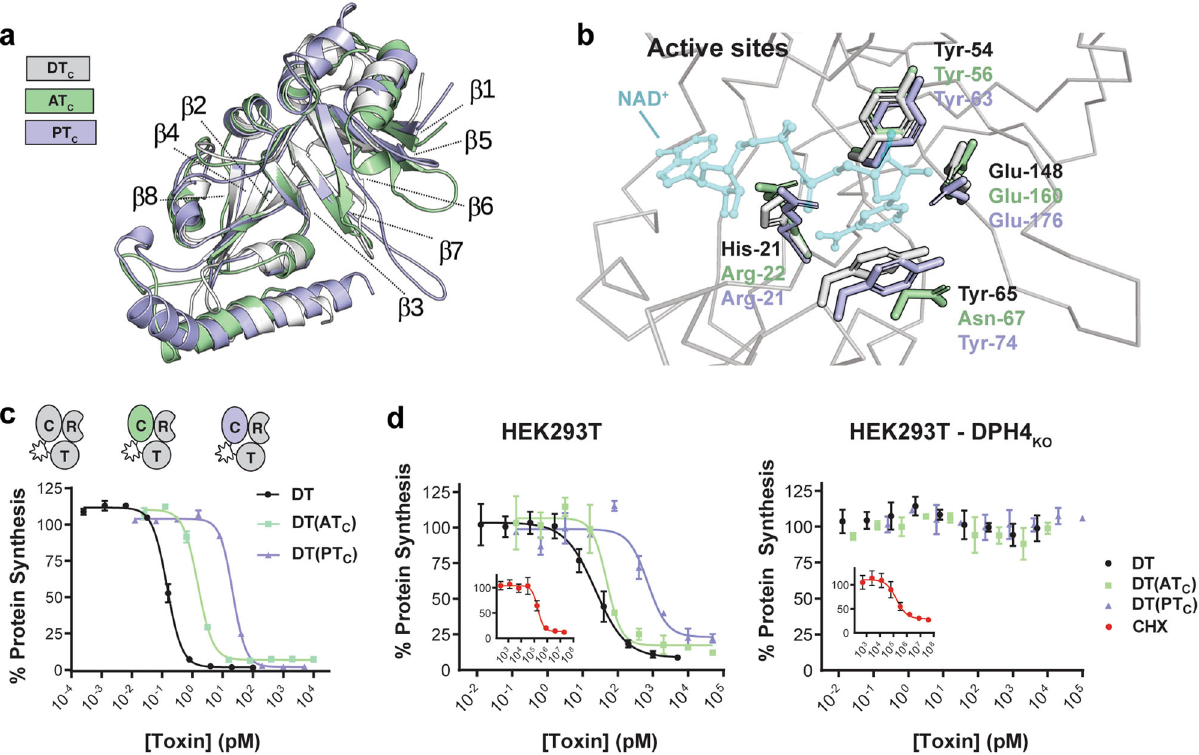
Fig. 4 The catalytic moieties from AT and PT are cytotoxic. a Overlay of C-domains highlighting the conserved split β -sheet characteristic of ADPRT fold proteins. b Active site residue conservation. DT residues important for NAD + binding and catalysis and corresponding residues in AT and PT are represented in stick form. NAD + represented in partial transparency is modeled from PDB entry 1TOX for reference. c Dose titration of DT and DT C-domain chimeras DT(AT C ), DT(PT C ) on Vero cells (mean ± SD, n = 2); n = 3 biological replicates. d Dose titration of DT, DT(AT C ), and DT(PT C ) on HEK293T and HEK293T DPH4 KO cells (mean ± SD, n = 2); n = 3 biological replicates. Titration of protein synthesis inhibitor cycloheximide (CHX) is shown in red